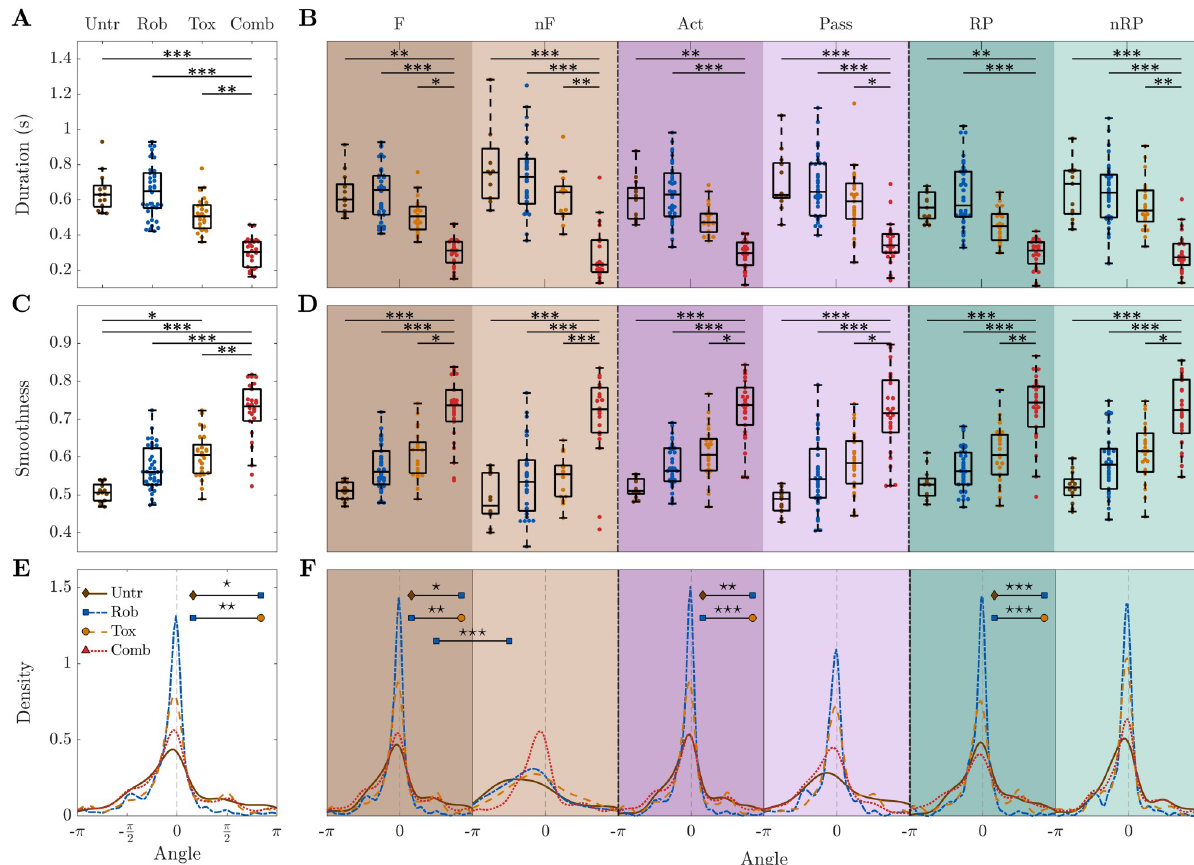
Fig 6. Combined treatment group is characterized by higher smoothness and shorter duration than any other group. For all types of event, combined treatment group events are the shortest (A-B) and their smoothness is the highest (C-D) . For the combined treatment group the distribution of the angles does not vary depending on the type of event (E-F) .—Results refer to the fourth week of recording after stroke. Duration and angle are weighted by smoothness. Markers in (A-D) refer to the average value per day. In (A,C) each point is the average of all events per day per mouse, while in (B,D) each point is the average of all events of a specific type per day per mouse. Within each box in (A-D), the central mark indicates the median, and the bottom and top edges of the box indicate the 25 th and 75 th percentiles, respectively. Untreated stroke group n = 4 mice, robot group n = 8 mice, toxin group n = 5 mice, combined treatment group n = 6 mice. For P-values of statistical tests see S3 Table, “ ? ” refers to difference in variance and “ � ” refers to difference in